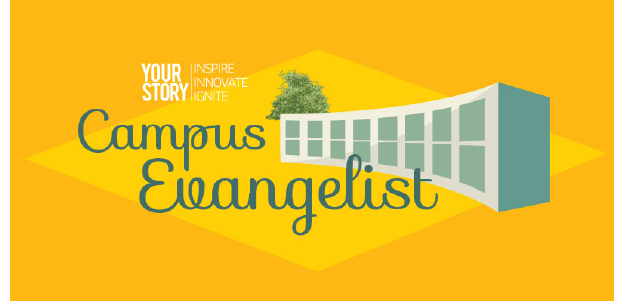
Fig. 2. System home